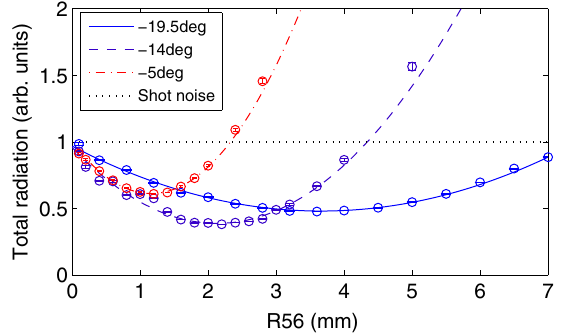
FIG. 3. Scan of undulator radiation amplitude vs R 56 . Colors correspond to different gun phase setting (and thus peak current), and lines are quadratic fits to the data. At larger peak currents, the interaction is stronger, leading to suppression at smaller R 56 values. Shot noise level (dotted line) is determined by inserting an OTR screen. (The − 5 deg case uses the − 14 deg case normalization.)